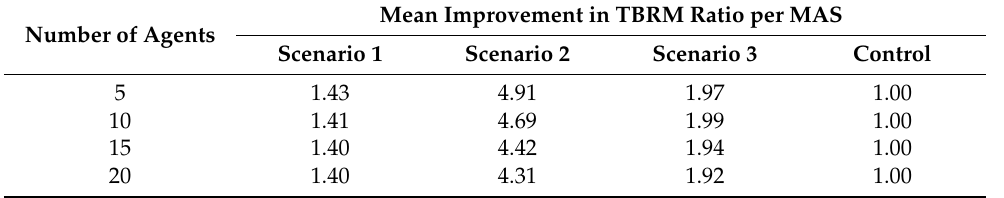
Table 12. Mean results from each scenario in comparison with the control group with respect to the number of agents in each